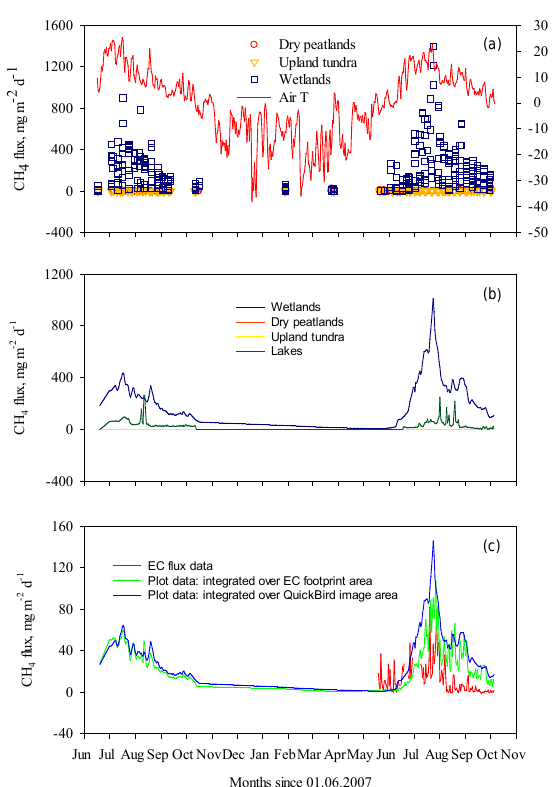
Figure 3. Seasonal distribution of daily values of chamber and EC measured CH 4 fluxes during the period from July 2007 to October 2008. Top panel: raw data as measured by the chamber method at dominant terrestrial land cover types (LCTs); Middle panel: daily mean fluxes measured using chambers at terrestrial LCTs and lakes interpolated over the study period; Bottom panel: a comparison of the daily fluxes measured using EC technique with the plot-scale chamber data integrated over the EC footprint area and over the QuickBird map area for the whole study region of 98.6km 2 .